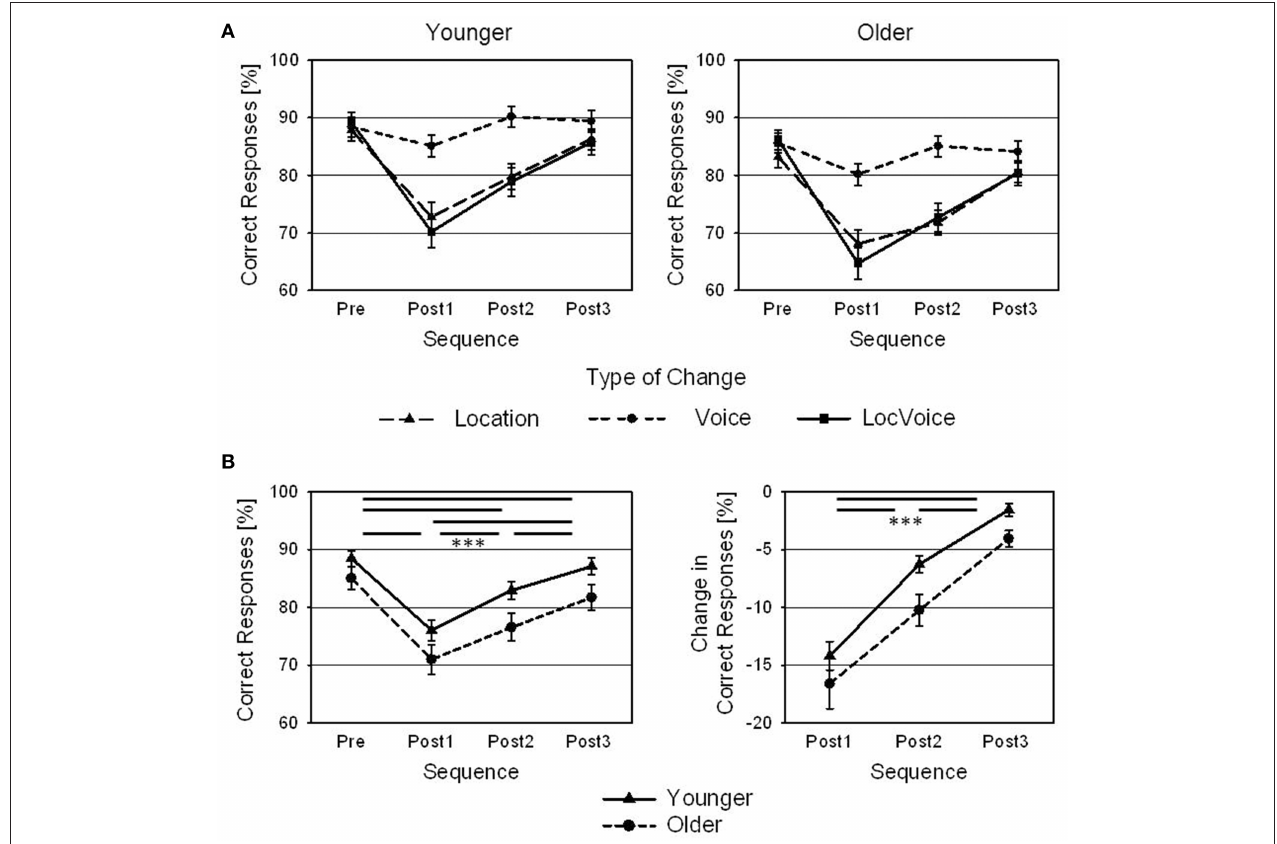
FIGURE 2 | Behavioral results. (A) Rates of correct responses of younger and older adults for Pre, Post1, Post2, and Post3 sequences, and for changes in target speaker location, voice, and combined changes in location and voice (LocVoice). (B) Rates of correct responses (left panel) and changes in the rate of correct responses (same data normalized with reference to pre-change levels; right panel) of younger and older adults, averaged across all types of changes, shown for Pre, Post1, Post2, and Post3 sequences. Error bars are standard errors across participants ( N = 22 ; *** p < 0.001).